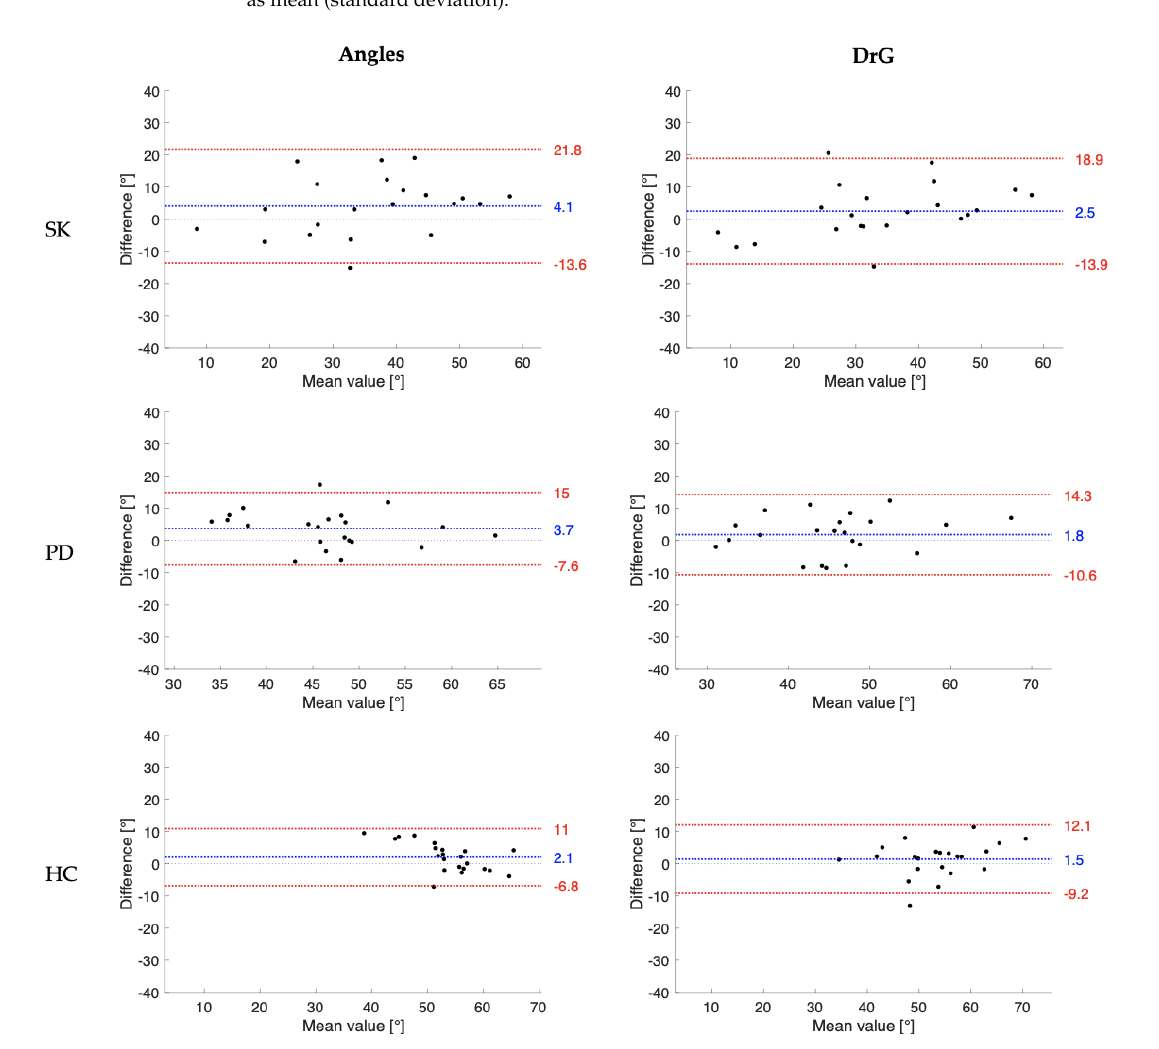
Figure 2. Bland-Altman plot of the knee range of motion of the three participant populations (SK: post-stroke patients, PD: patients with Parkinson’s disease, HC: healthy controls) collected by the experienced examiner (E1) using the Angles and the DrGoniometer applications. The blue line indicates the mean differences between the mobile app and electro-goniometer measures, and the red lines are the 95% lower and upper limits of agreement.